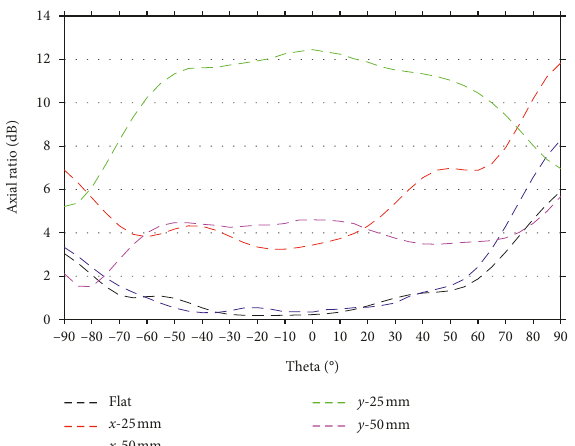
Figure 10: Measured AR in flat and bent x - and y -directions at 2.45 GHz at φ � 0 ° .